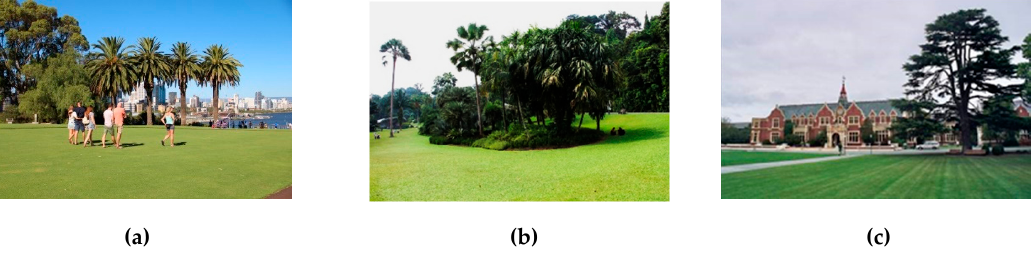
Figure 10. Ecological homogenization of urban environment in ( a ) Australia (Perth), ( b ) Singapore (Singapore Botanic Garden) and ( c ) New Zealand (Lincoln University Campus). Photos: M. Ignatieva.